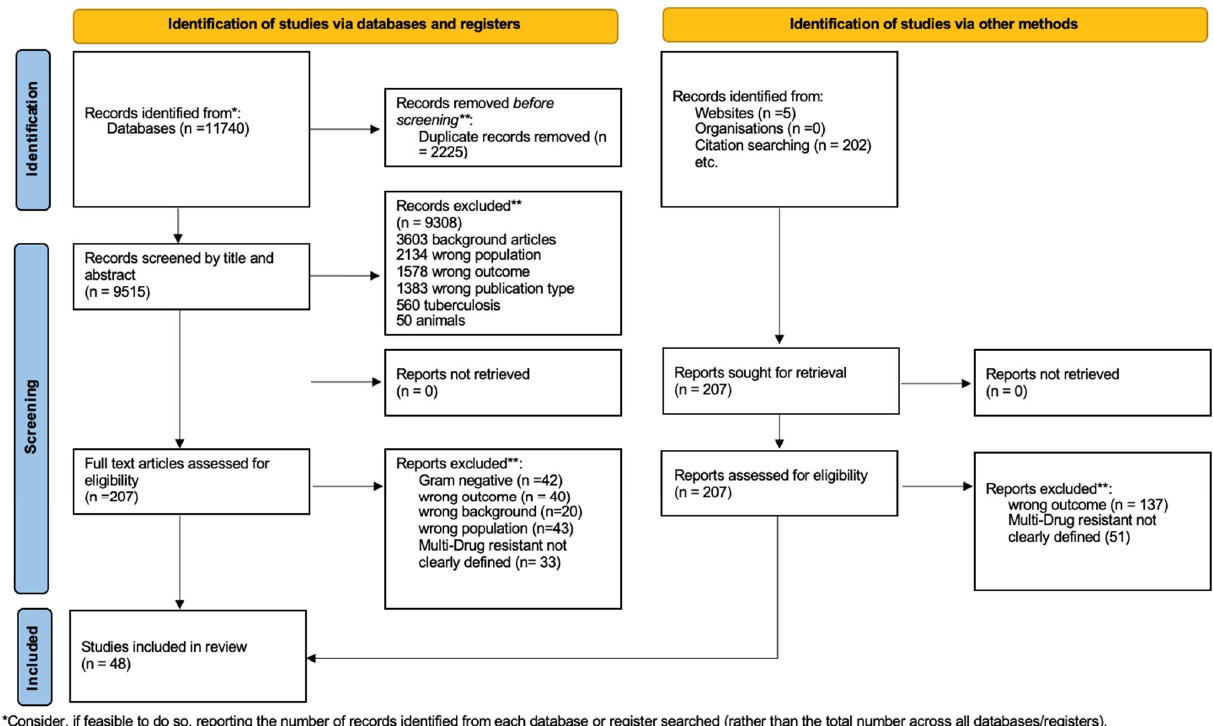
Figure 1. Flowchart of the study selection process.